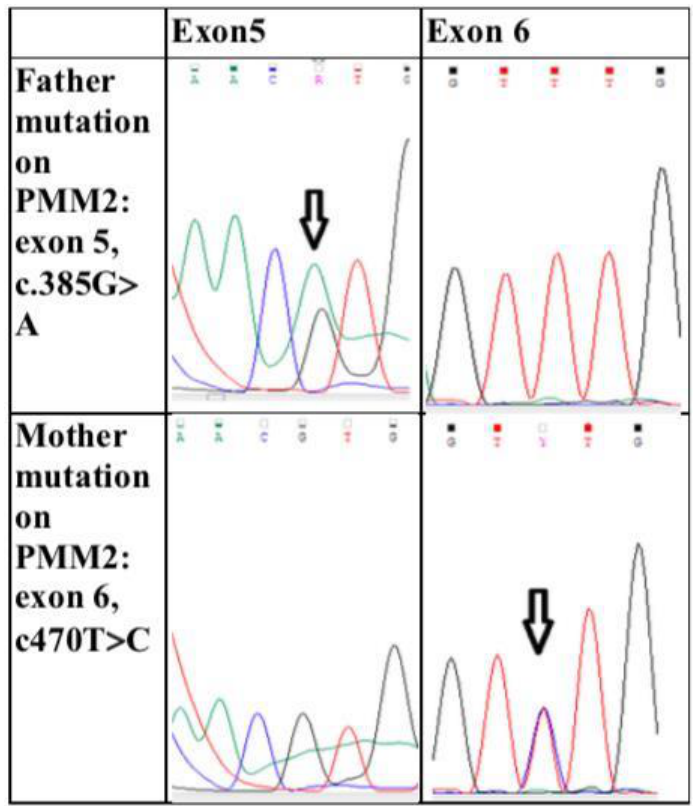
Figure A7. Male embryo with father mutation on PMM2, exon 5, c.385G>A, and mother mutation on PMM2, exon 6, c.470T>C.